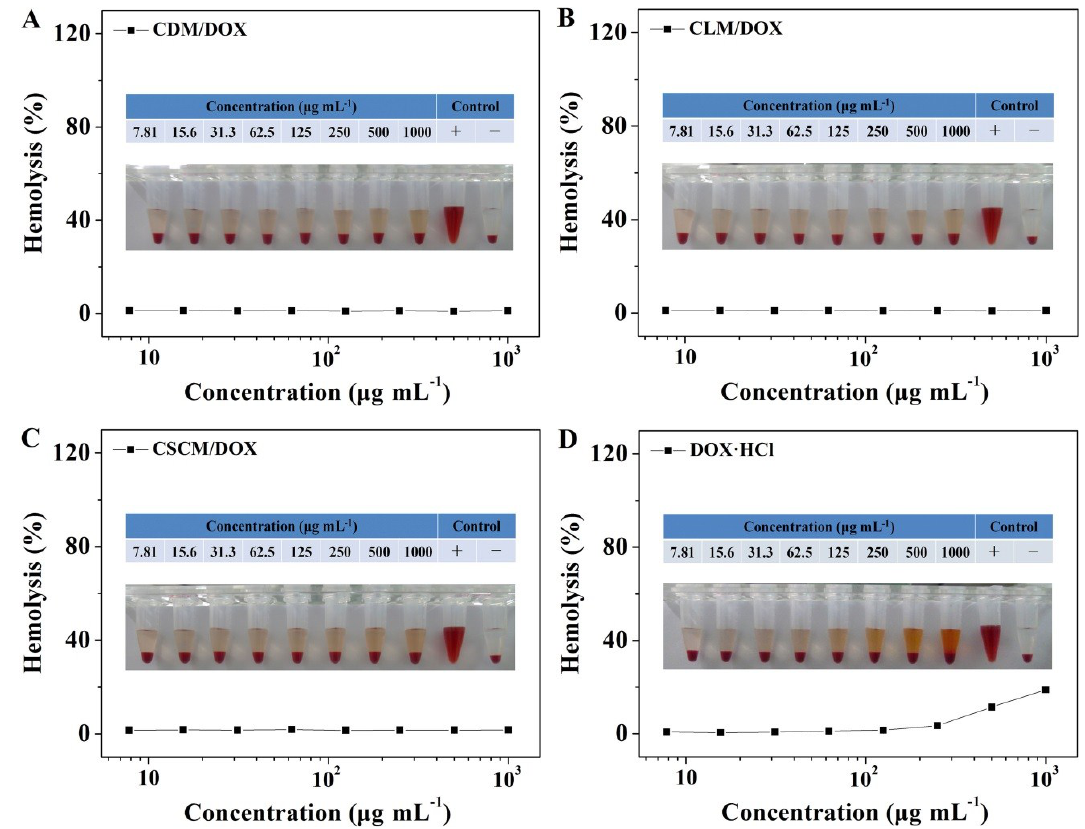
Figure 7. Hemolysis behaviors of CDM/DOX ( A ); CLM/DOX ( B ); CSCM/DOX ( C ); and free DOX·HCl ( D